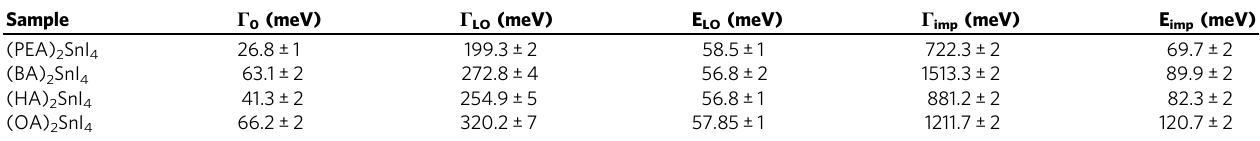
Table 1 Best- fi tting parameters of the (PEA) 2 SnI 4 , (BA) 2 SnI 4 , (HA) 2 SnI 4 , and (OA) 2 SnI 4 perovskites.